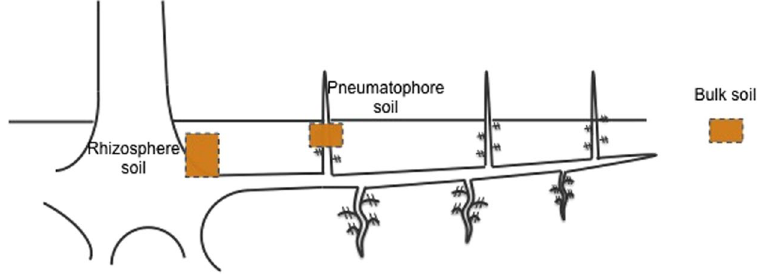
Figure 1. The schematic representation of sampling of three different soil